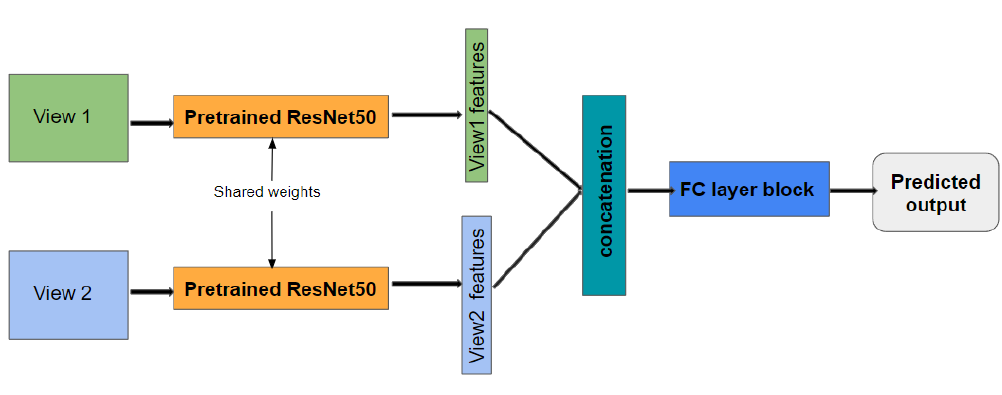
Figure 13. The proposed Siamese architecture for multi-view